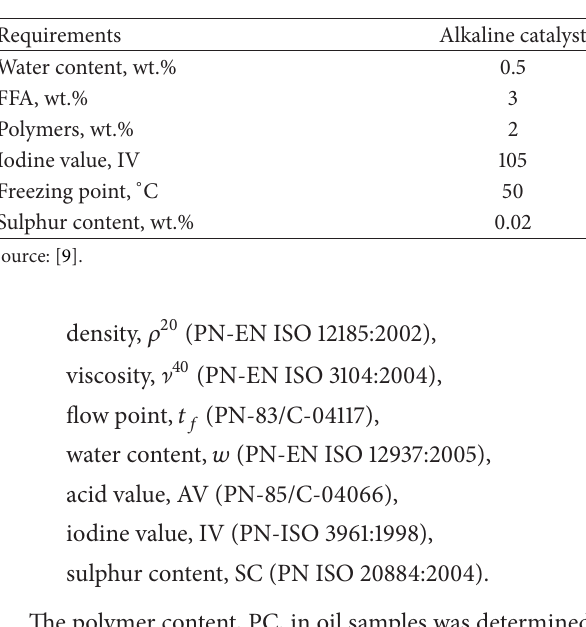
Table 4: Requirements for Vogel & Noot GmbH